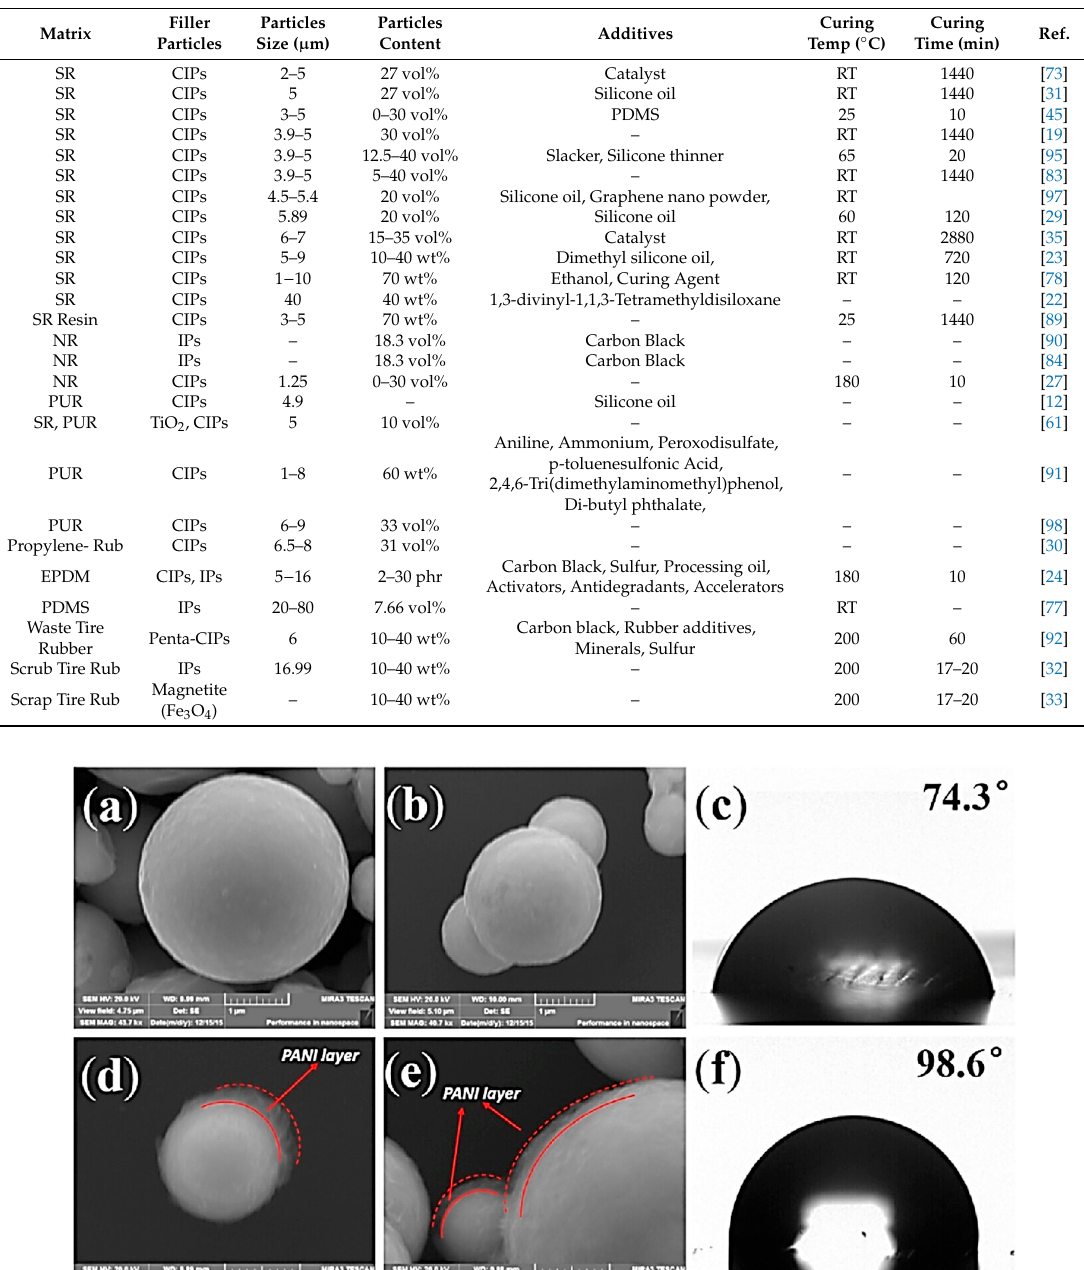
Table 1. Elastomers, filler particles, additives, and key parameters used for the fabrication of isotropic MREs. PDMS—polydimethylsiloxane; PUR—polyurethane; SR—silicone rubber; EPDM—ethylene propylene diene rubber.